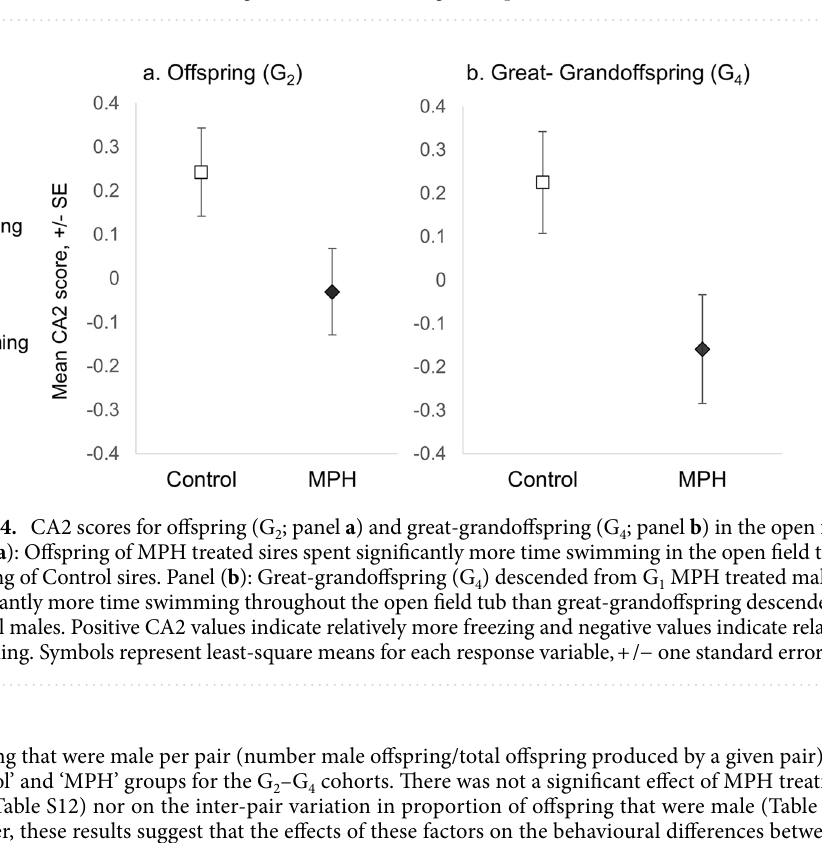
offspring that were male per pair (number male offspring/total offspring produced by a given pair) differed for ‘Control’ and ‘MPH’ groups for the G 2 –G 4 cohorts. There was not a significant effect of MPH treatment on sex ratio (Table S12) nor on the inter-pair variation in proportion of offspring that were male (Table S13). Taken together, these results suggest that the effects of these factors on the behavioural differences between ‘Control’ and ‘MPH treated’ lines were minimal. Because MPH functions by regulating the dopaminergic pathway 45,46 , we measured whole brain dopamine concentration for a subset of individuals from the G 2 to G 4 cohorts immediately following behavioural testing (SI Methods for detail). Contrary to our prediction, there was not a significant effect of G 1 male treatment on whole brain dopamine concentration for any generation tested (G 2 to G 4 , all P > 0.5; Table S15).